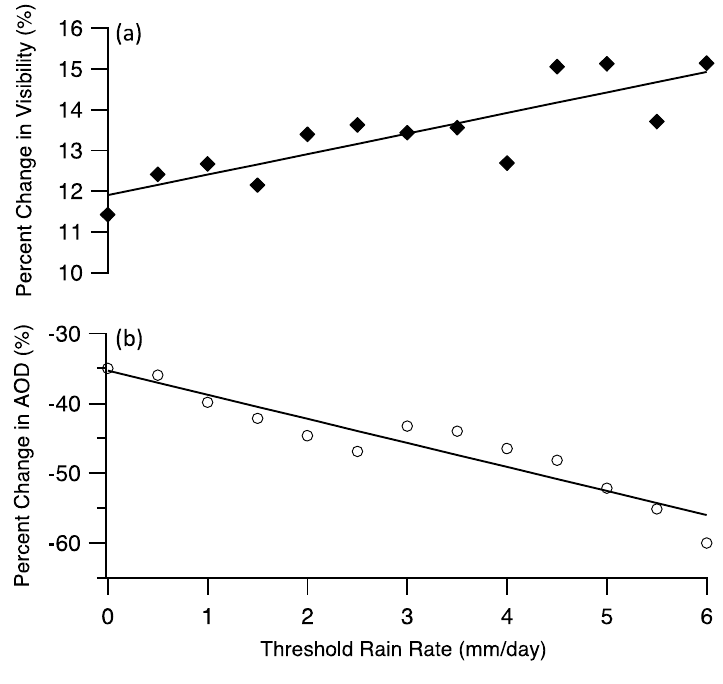
Figure 7. Change in ( a ) visibility and ( b ) satellite-derived AOD immediately before and after rain days. The plots show the composite average difference between the mean visibility/AOD during the two days after rain and the two days before rain. The composite is taken for rain events, which exceed the given threshold daily rainfall rate and is presented as a percentage with respect to the mean visibility/AOD before the